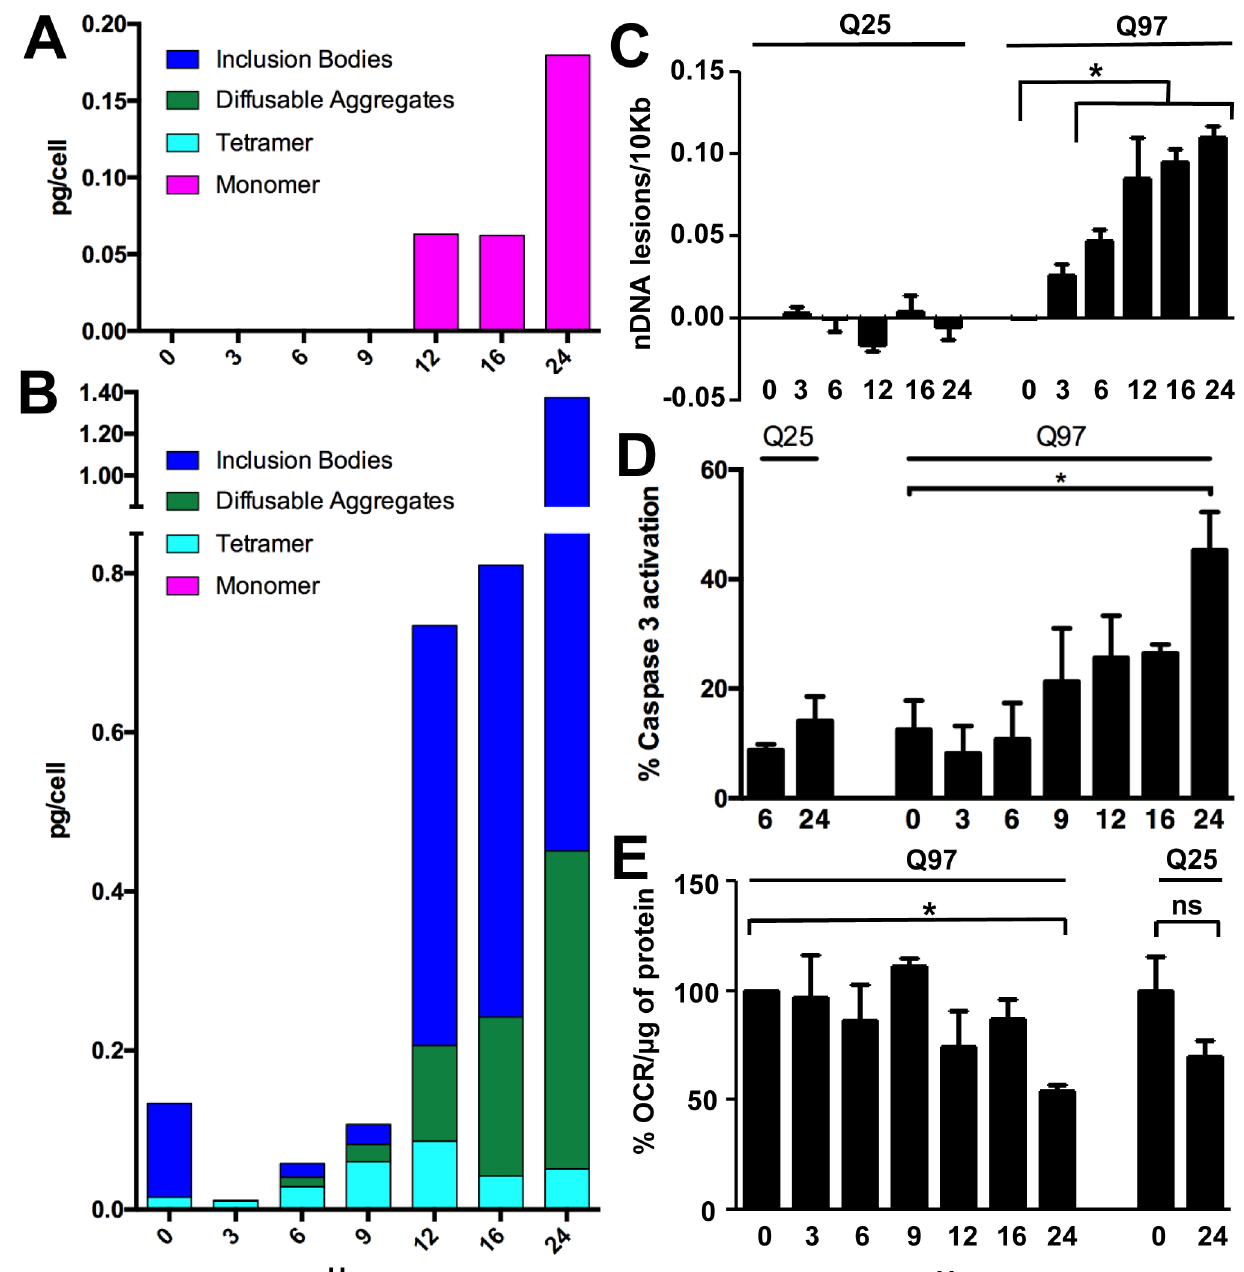
Fig 5. Time courses of PC12 cell responses to HTT exon1 expression. A, B. Cell levels of monomer, tetramer, diffusible aggregates and inclusions in cells producing HTT exon1-Q 25 -EGFP (A) or HTT exon1-Q 97 -EGFP (B) analyzed at different times after onset of growth with inducer. In A, FCS measurements yielding information on monomers, dimers/tetramers, and diffusible oligomers were made 12, 16 and 24 hrs. In B, except for the lack of a measurement for inclusions at 3 hrs, absence of a value for a species indicates a measurement yielding a value of zero. C, D, E. Growth time dependent effects of expression of HTT exon1 with a Q 25 or Q 97 repeat on nuclear DNA damage (C), caspase-3 activation (D) and cell mitochondrial respiration (E). OCR = oxygen consumption rate.